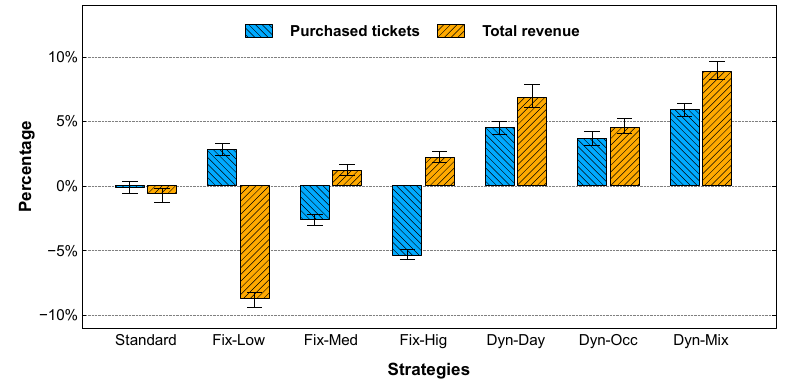
Figure 9. Comparative analysis among pricing strategies, evaluating the number of purchased tickets and the relative